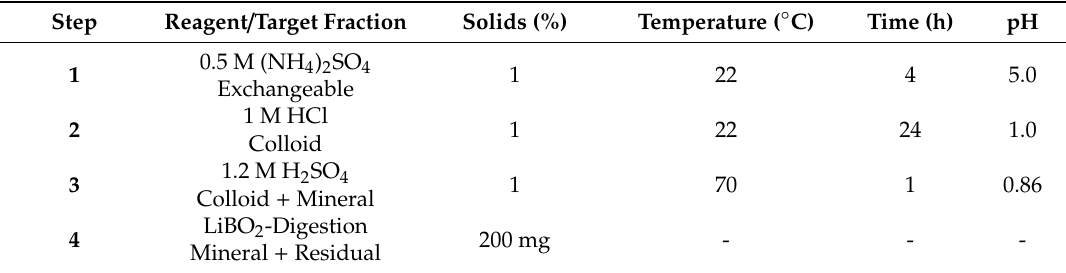
Table 2. Extraction reagents and conditions used in sequential extraction. Concentration of reagents shown in mol / L (M). Mass of